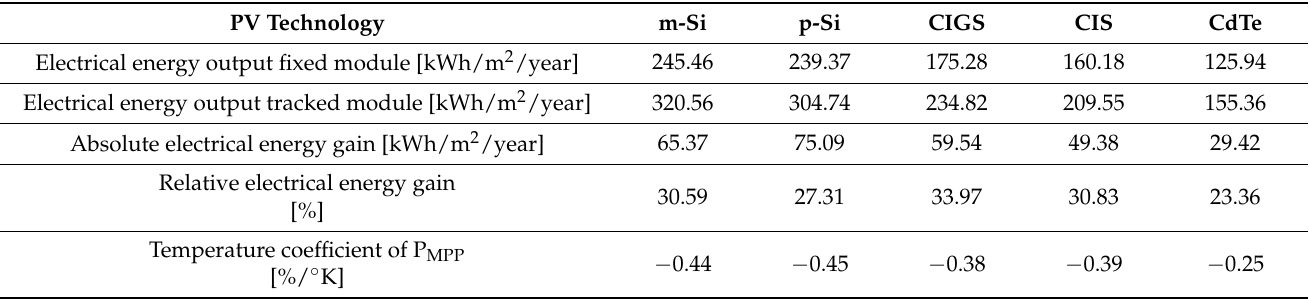
Table 3. Yearly electrical energy output and electrical energy gain of the 5 PV modules types installed on the fixed and tracked platform.